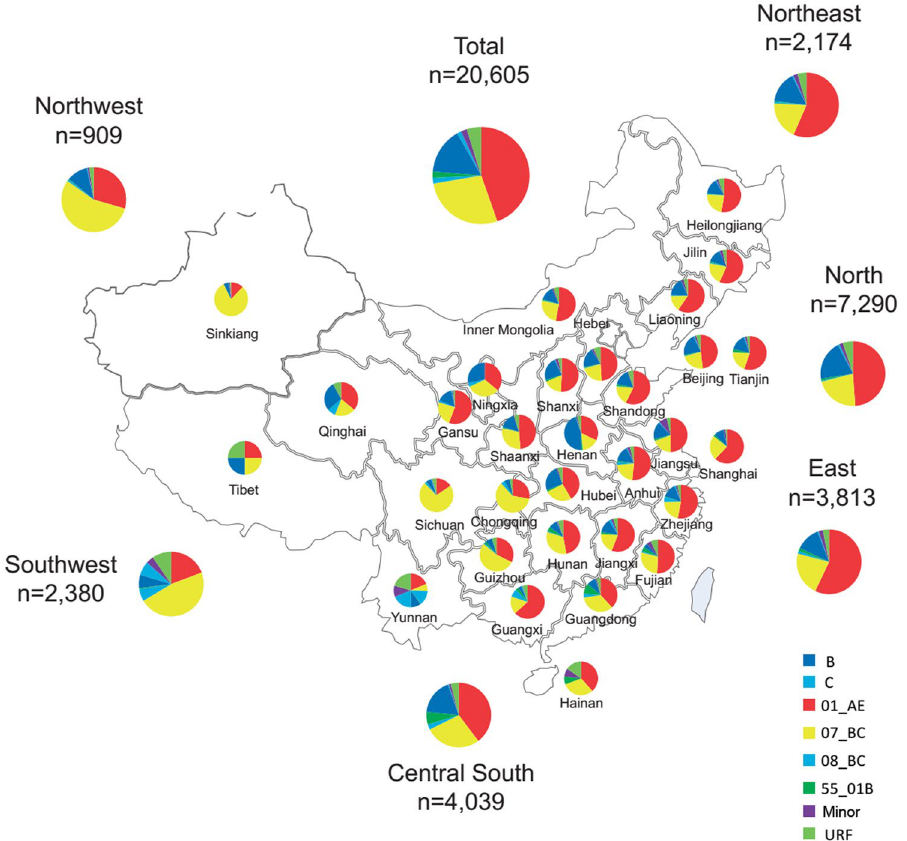
Figure 2. Geographical distribution of HIV subtype. Seven common subtypes, CRF01_AE, CRF07_BC, subtype B, URF, CRF55_01B, CRF08_BC, and subtype C. Samples were from 31 provinces of China. North, Beijing, Tianjin, Hebei, Shanxi, and Inner Mongolia; Northeast, Liaoning, Jilin, and Heilongjiang; East, Shanghai, Jiangsu, Zhejiang, Anhui, Fujian, Jiangxi, and Shandong; Central-south, Henan, Hubei, Hunan, Guangdong, Guangxi, and Hainan; Southwest, Chongqing, Sichuan, Guizhou, Yunnan, and Tibet; Northwest, Shann’xi, Gansu, Qinghai, Ningxia, and